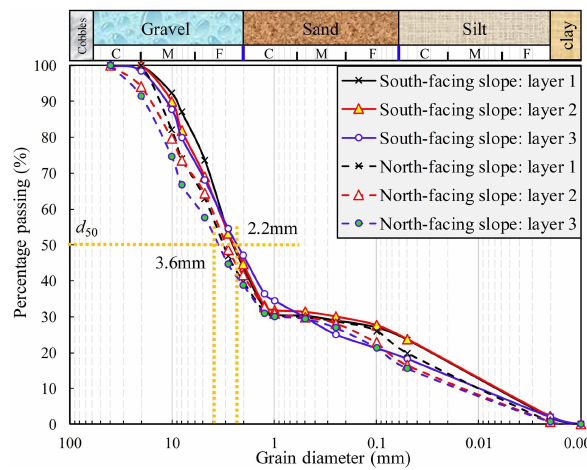
Figure 5. Soil particle component curves. The letters C, M, and F mark the coarse, medium, and fine scale.